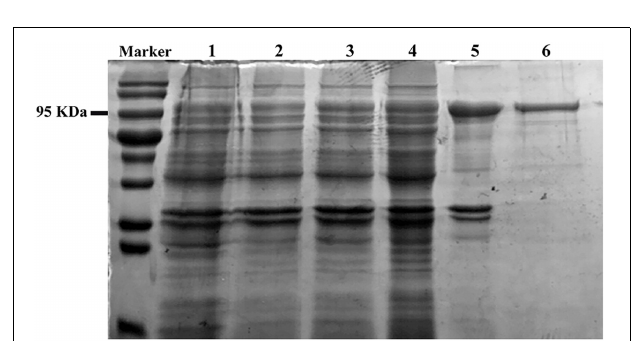
FIGURE 2 | Sodium dodecyl sulfate polyacrylamide gel electrophoresis analysis of the recombinant TtBgl3. The supernatant of the crude extracts of E. coli Rosetta (DE3) (Lane 1). The total protein of E. coli Rosetta (DE3) harboring pET28b- TtBgl3 without (Lane 2); the total protein (Lane 3), supernatant (Lane 4), and precipitation (Lane 5) of E. coli Rosetta (DE3) harboring pET- TtBgl3 treated by IPTG at the concentration of 0.1 mM. The recombinant TtBgl3 purified by Ni-NTA resin affinity chromatography and ultrafiltration (Lane